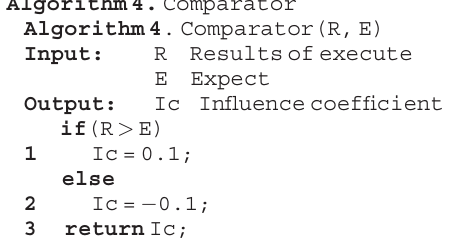
Algorithm 4. Comparator Algorithm 4 . Comparator(R,